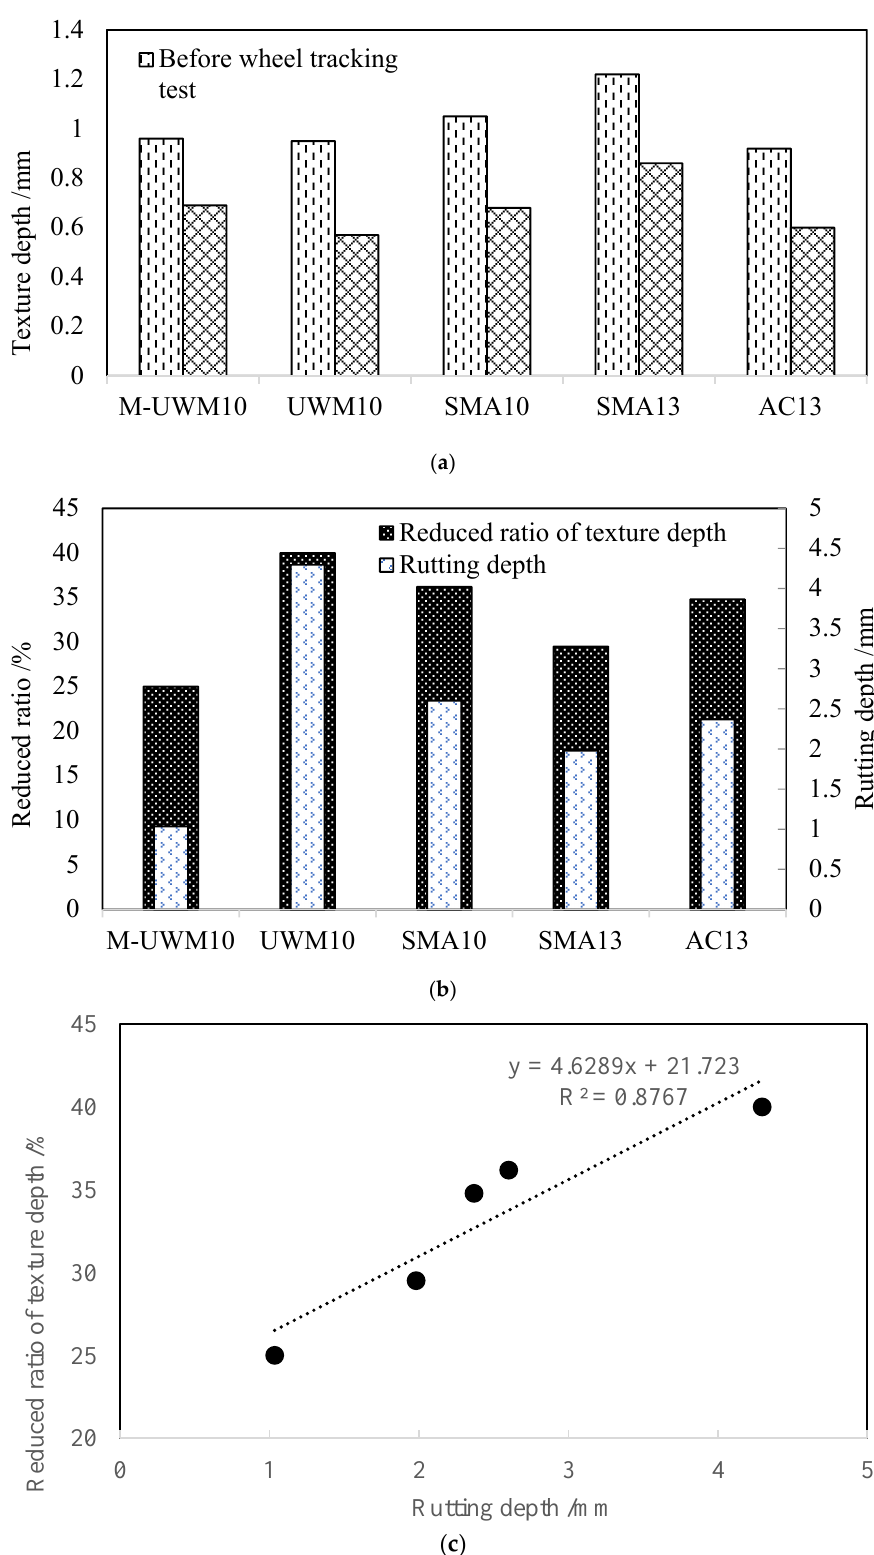
Figure 6. Test results from the combination of the texture depth test and the wheel tracking test: ( a ) texture depth before and after wheel tracking test; ( b ) loss ratio of texture depth after wheel loading. ( c ) correlation between the reduced ratio of texture depth and the rutting depth after the wheel tracking test.